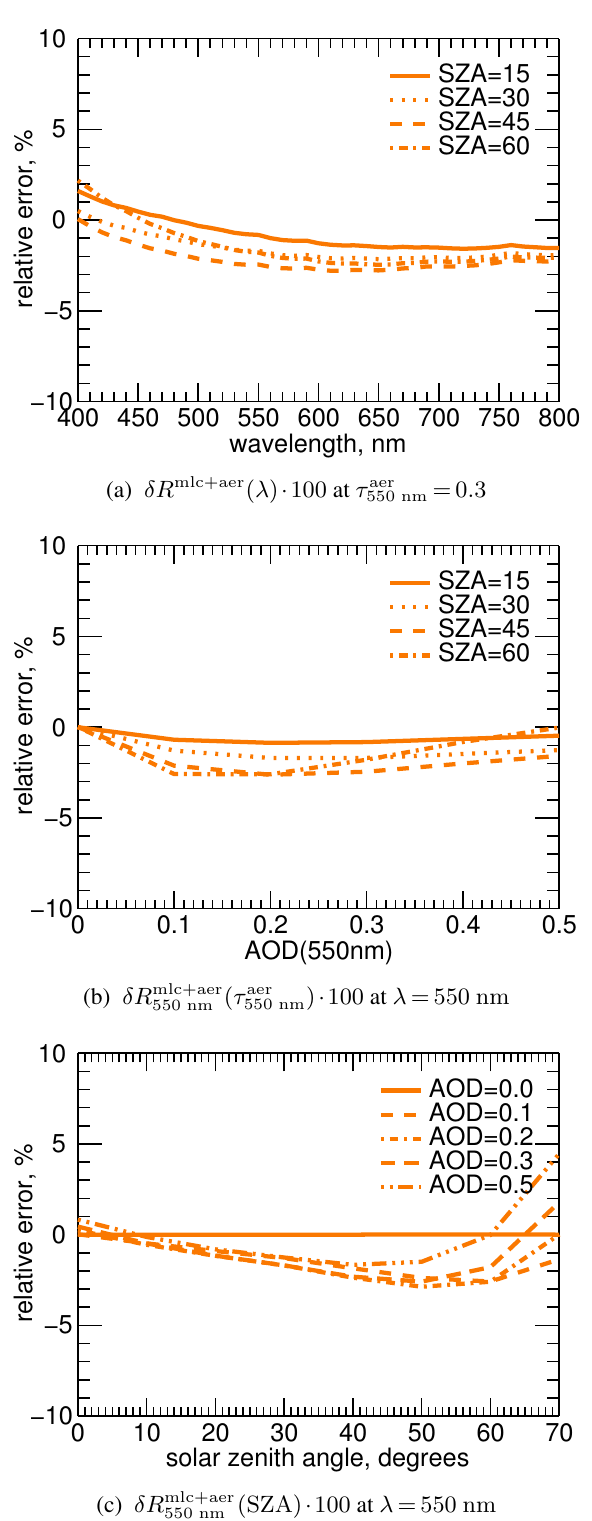
Fig. 4: Percent error of the SMART reflectance function due Fig. 5: . Percent error due to the non-coupling approximation Fig. 5. Percent error due to the non-coupling approximation with to aerosol scattering with respect to wavelength, aerosol op- with respect to wavelength, aerosol optical depth (AOD) and respect to wavelength, aerosol optical depth (AOD) and solar zenith tical depth (AOD) and solar zenith angle (SZA) at top-of- solar zenith angle (SZA) at top-of-atmosphere. angle (SZA) at top-of-atmosphere. atmosphere. SMART uses the HG phase function, 6S the phase function from Lorenz-Mie theory.